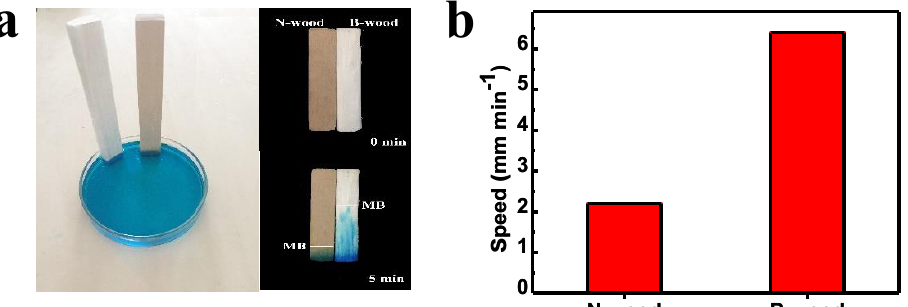
Figure 2. ( a ) The MB transport distance through B-wood and N-wood after 0, 5 min. ( b ) The MB transport speed through B-wood and N-wood during 5 min.